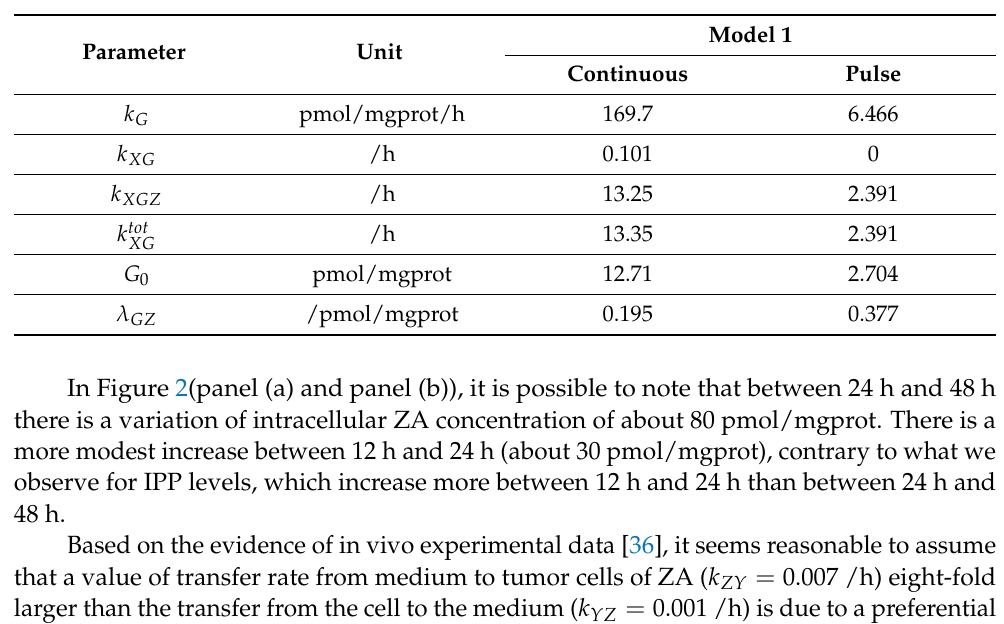
Figure 2. Model 1 simulation trend in the continuous experiment. Panel ( a ) shows the simulated zoledronate ( ZA ) trend over time; panel ( b ) shows the simulated antigen ( IPP ) trend over time. The continuous blue line represents the model forecast, while red asterisks represent the experimental data obtained by [39]. Table 4. Model 1: IPP antigen dynamics sub-model